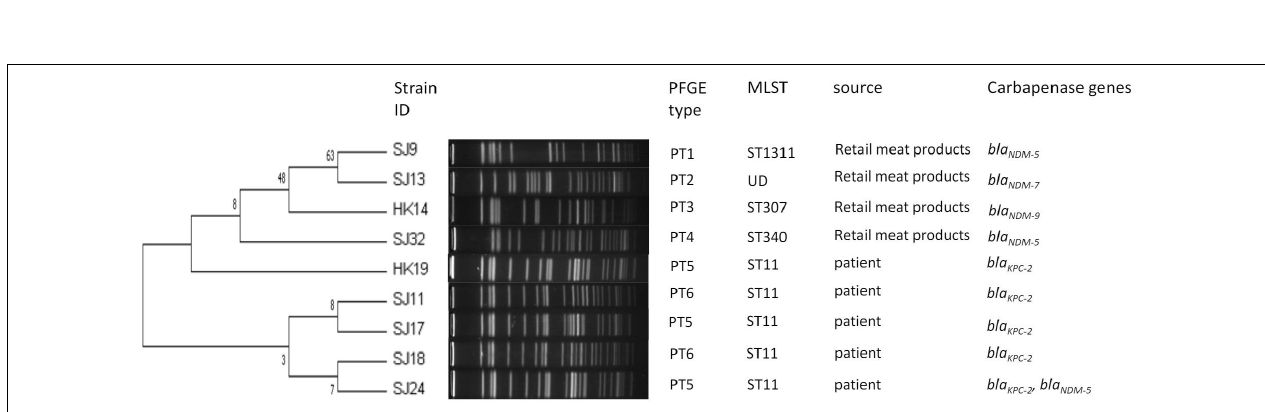
FIGURE 2 | Dendrogram of PTs of chromosomal DNA restriction fragments from nine K. pneumoniae isolates in the present study. Allelic profiles, PTs, STs, source information, and carbapenemase genes.